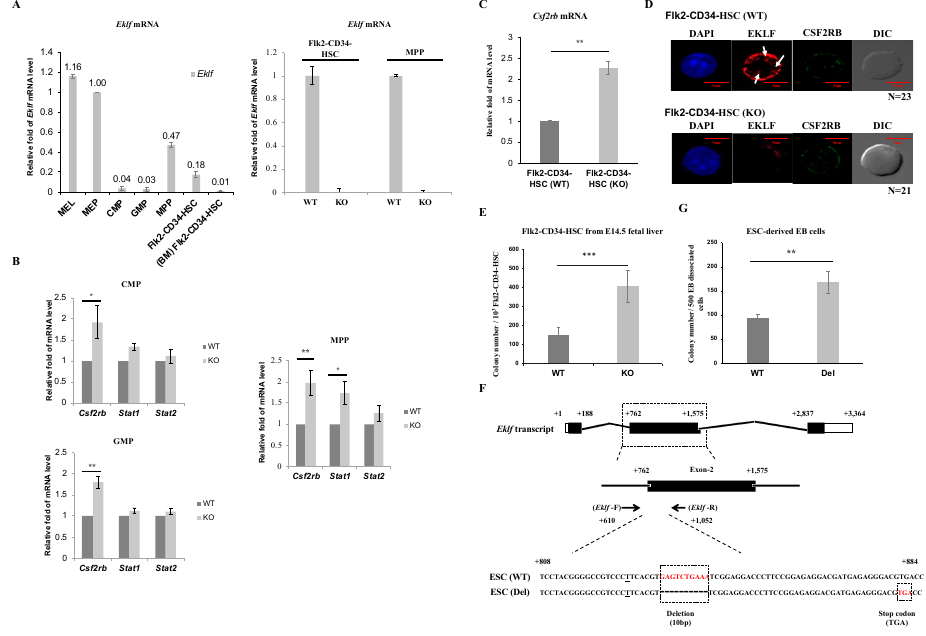
Figure 2. Regulation of Flk2-CD34-HSC differentiation by EKLF ( A ) RT-qPCR analysis of RNAs isolated from different types of mouse hematopoietic stem cells and progenitors, including LT-HSCs, MPPs, CMPs, GMPs, and MEPs purified from E14.5 mouse fetal liver and Flk2-CD34-HSCs from bone marrow (BM Flk2-CD34-HSC) by FACS. The relative levels of Eklf mRNA in all of the progenitor cells are compared to that of mouse erythroleukemia (MEL) cells in the left panel, with the level in MEP set as 1. The comparative RT-qPCR analyses of Eklf mRNA in Flk2-CD34-HSCs and MPPs of E14.5 fetal livers from WT and KO ( Eklf − / − ) embryos are shown in the right panel. ( B ) RT-qPCR analysis of the mRNA levels of Csf2rb , Stat1 , and Stat2 in purified CMPs, GMPs, and MPPs. Five biological replicates were analyzed for each type of cells. Each bar represents mean ± standard deviation. * p < 0.05, ** p < 0.01. ( C ) Relative levels of Csf2rb mRNA in Flk2-CD34-HSC purified from WT and KO E14.5 mouse fetal livers were analyzed by RT-qPCR. n ≥ 5. ** p < 0.01. ( D ) Representative immuno-fluorescence staining patterns of the expression patterns of EKLF and CSF2RB in Flk2-CD34-HSCs (WT) and Flk2-CD34-HSCs (KO). DAPI (49-6-diamidino-2-phenylindole) is the nucleus marker. Note the lack of EKLF signal in Flk2-CD34-HSCs (KO). Three biological replicates were analyzed. The diameters of LT-HSCs range from 5–10 μ m. EKLF signal present in the nucleus (white arrow). ( E ) Colony-forming cell (CFC) assay was performed on Flk2-CD34-HSCs (WT) and Flk2-CD34-HSCs (KO) purified (>90%) from E14.5 fetal liver cells by flow cytometry. n ≥ 4. *** p < 0.001. ( F ) Top, map of Eklf transcript with 3 exons. Middle, Eklf exon 2 as the target of gDNA. Bottom, comparison of the genomic sequence of the CRISPR/Cas9-edited Eklf exon 2 region in ESC (Del) to the wild-type sequence in ESC (WT). The Eklf -F and Eklf -R PCR primers used for validating the sequences are indicated. Note the presence of 10 bp deletion in ESC(Del) that causes a frame shift and consequent pre-mature termination TGA codon. ( G ) CFC assay of embryoid body (EB) cells derived from wild-type ESC(WT) and from CRISPR/Cas9-edited ESC, i.e., ESC(Del), respectively. n = 3. ** p < 0.01. Homeostasis of the hematopoietic system depends, in part, on the balance of the self-renewal of Flk2-CD34-HSCs and proliferation of the different hematopoietic precursors with their differentiation capabilities, which are modulated by various cytokines and signal transduction